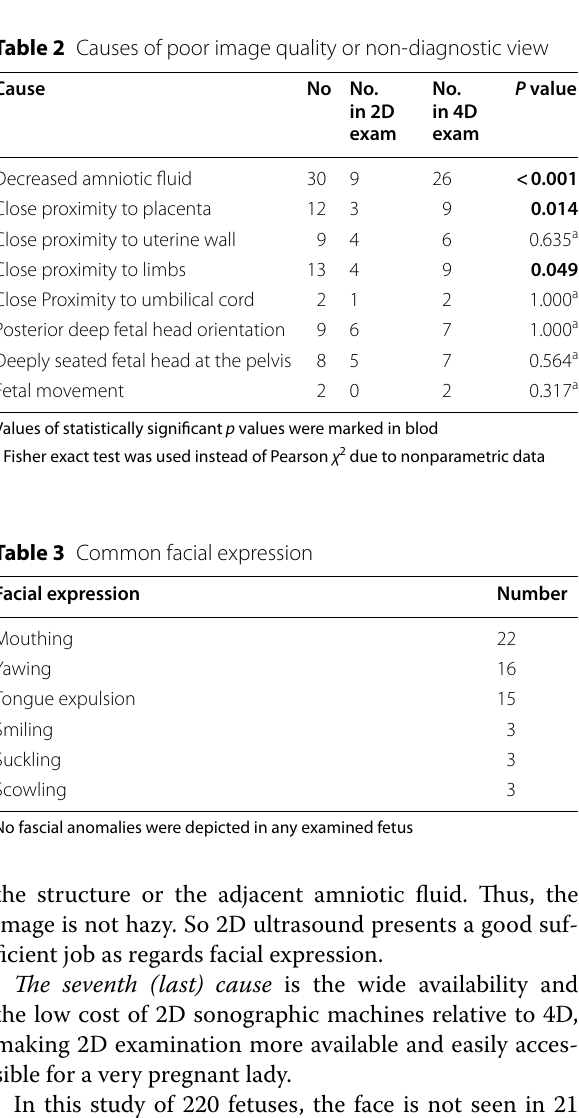
Table 2 Causes of poor image quality or non-diagnostic view